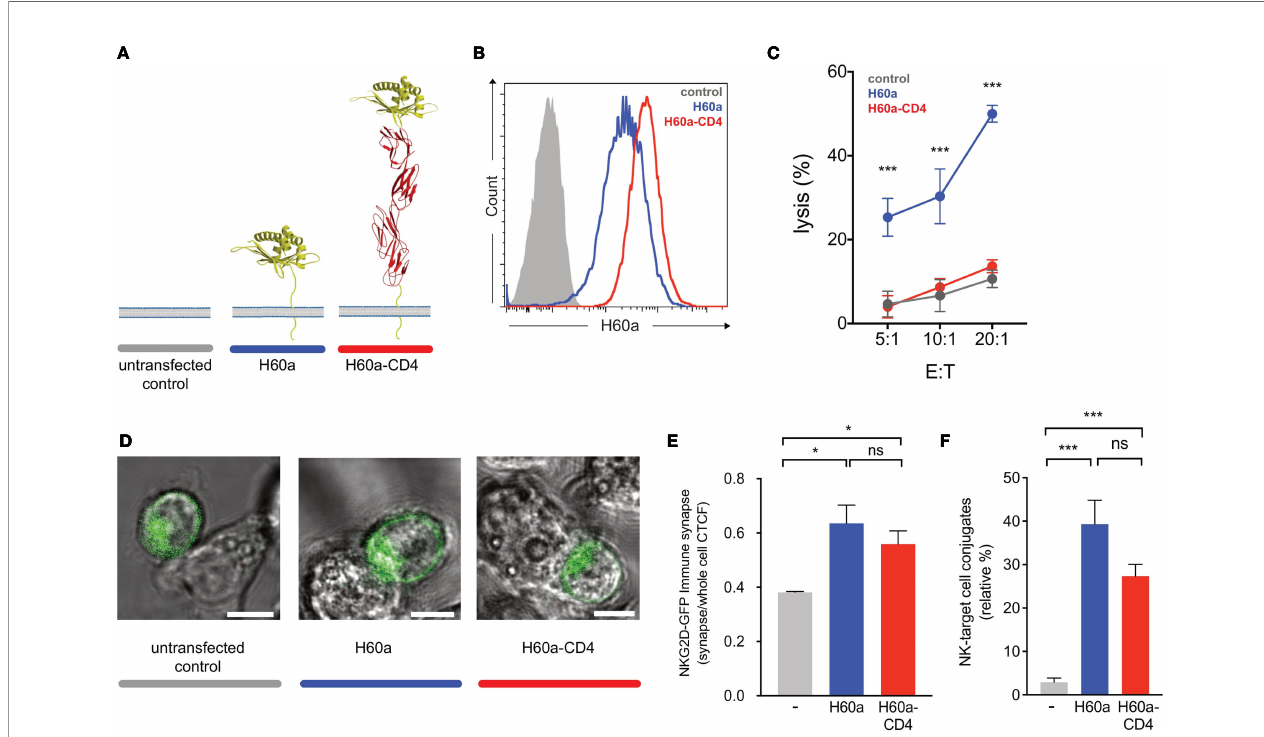
FIGURE 4 | Activating ligand dimensions affect natural killer (NK) cell activation. (A) Schematic representation of H60a NKG2D ligand and its elongated form. The insertion of four IgSF domains creates a predicted elongation of 12 nm. For illustrative purposes, the RAE-1B structure was used to represent H60a. (B) H60 cell surface staining of RMA transfectants (antibody clone 205326, R&D Systems). The control (solid gray) corresponds to untransfected RMA cells; H60a (blue) and H60a-CD4 (red) correspond to RMA clones with similar levels of ligand expression. (C) Elongation of H60a reduces NK cell activation. Untransfected RMA (control, gray) and RMA H60a (H60a, blue), and RMA H60a-CD4 (H60a CD4, red) transfected cells expressing similar levels of ligands were used as target cells. IL-2-expanded NK cells from C57BL/6 mice were used in a killing assay at the indicated effector/target ( E : T ) ratios. Data show the mean ± SD %lysis (n = 3), and the groups with a statistically signi fi cant difference are shown as follows: *p < 0.05, ***p < 0.001; ns, no statistically signi fi cant difference (p > 0.05). Multiple unpaired t -tests were used by applying the Holm – Sidak method. Data are representative of two independent experiments. (D) Confocal z-stack live cell imaging of NKG2D short-GFP NK cells ex vivo by targeting untransfected, H60a, or